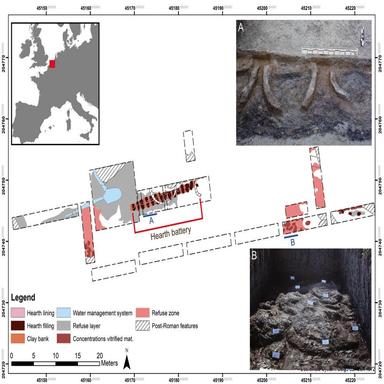
Simplified excavation plan of the late second-early third century CE salt production site of Leffinge (BE) depicting the hearth battery, water management systems and the refuse zones.